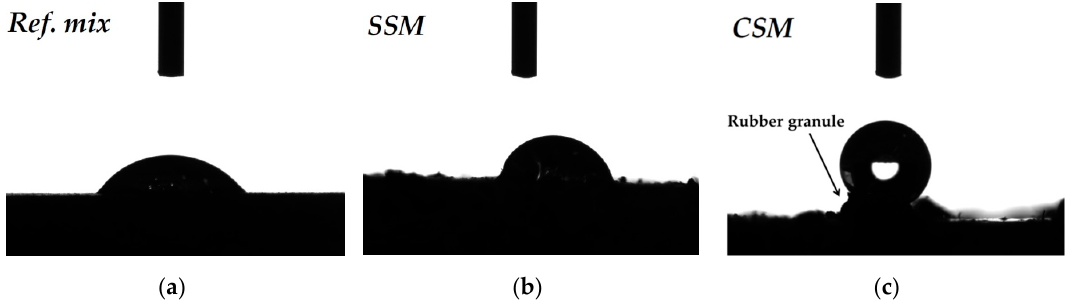
Figure 4. Water drop—cement surface interaction: Ref. ( a ), SSM ( b ) and CSM ( c ) samples.